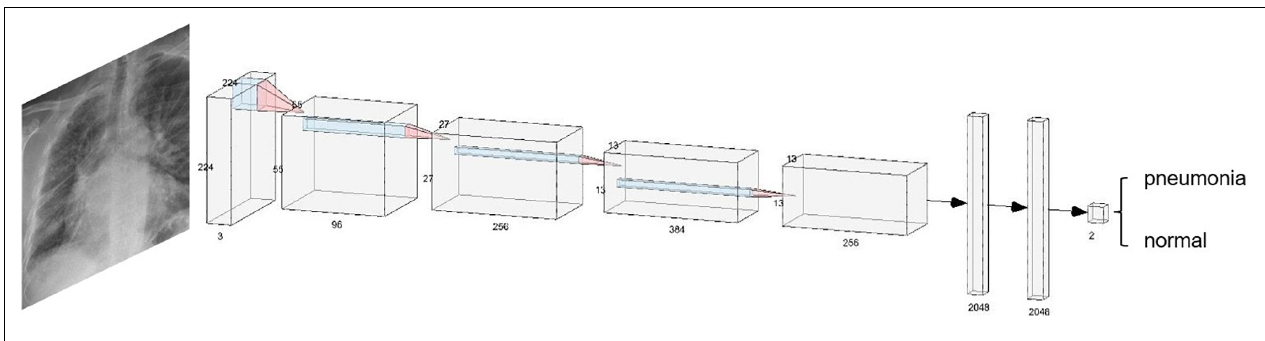
FIGURE 10 | Convolutional neural network structure for detecting pneumonia with chest X-ray images.